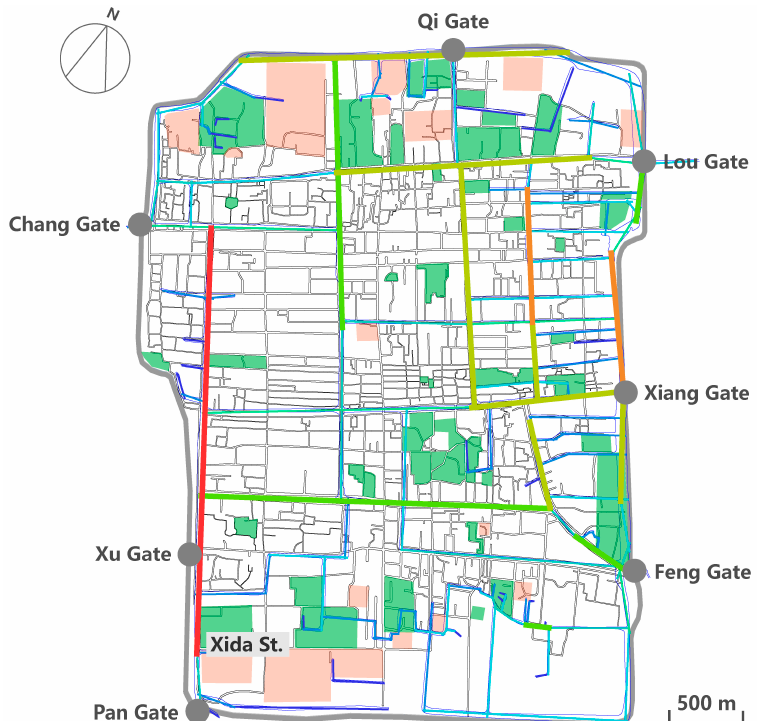
Figure 5. Canal axis model analysis results. Canals marked in red are the most integrated canals, and those marked in dark blue are the least integrated canals. Canals with a higher degree of integration have more intersections with other canals, and canals with a lower degree of integration have fewer intersections with other